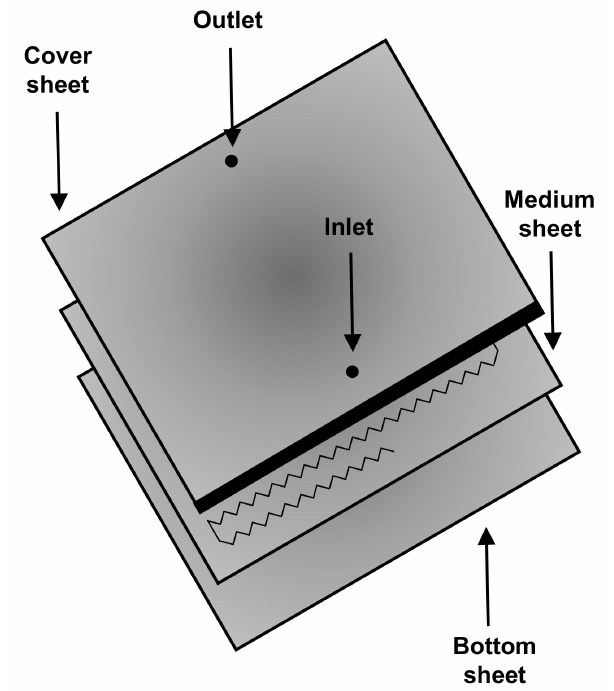
Figure 2. Zigzag microchannel